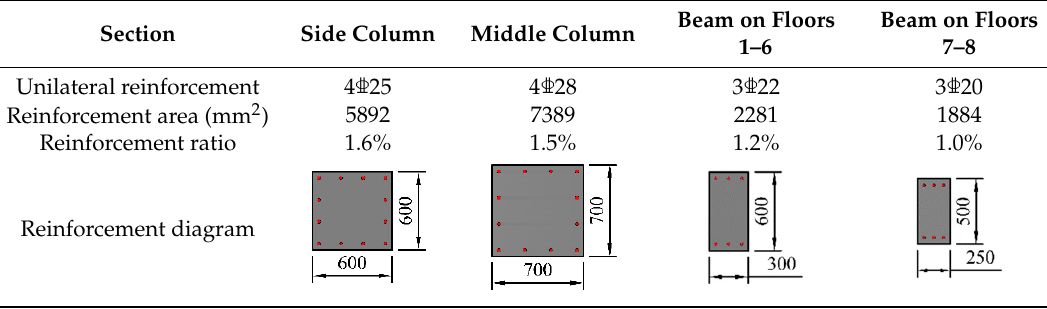
Figure 10. Frame load and plastic hinge arrangement. Table 1. Reinforcement of frame sections.